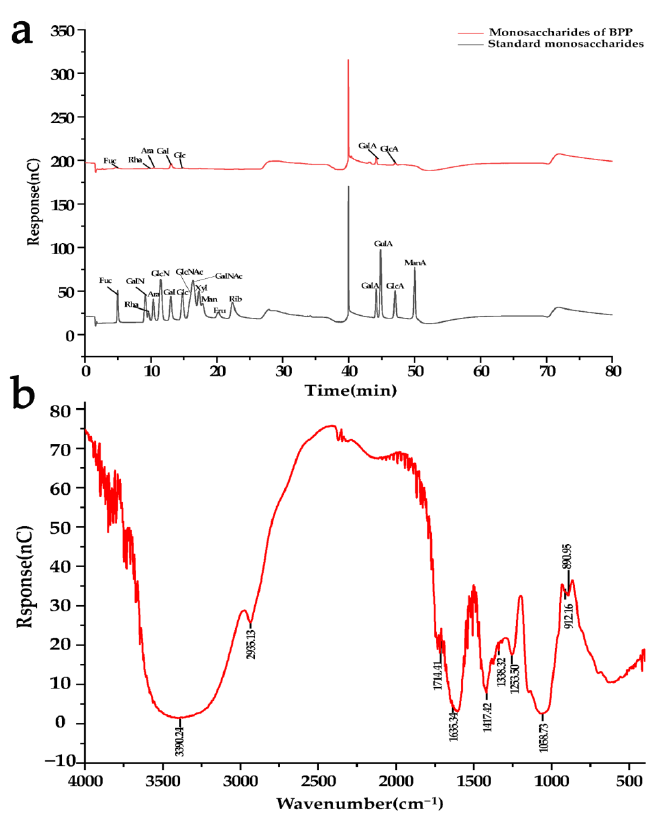
Figure 1. Structural characterization of BPP. ( a ) Molecular weight; ( b ) FT-IR spectrum